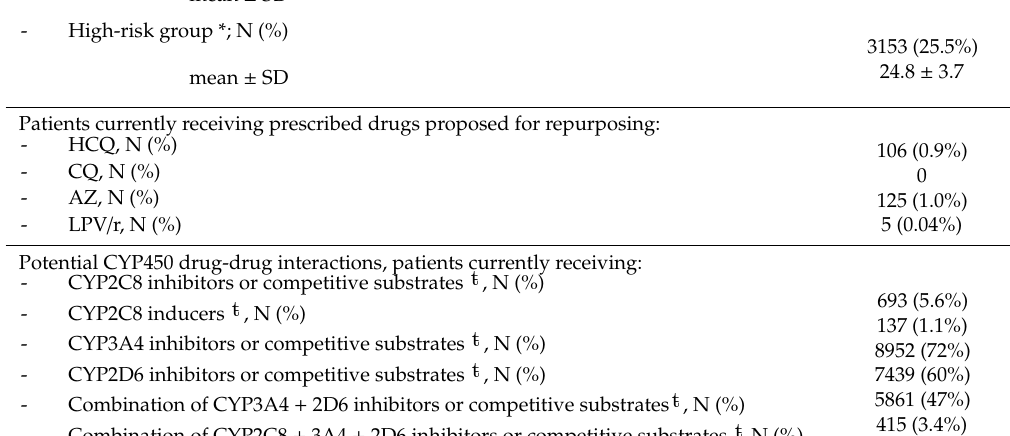
Table 6: Punctuation Marks Not Found in OT1